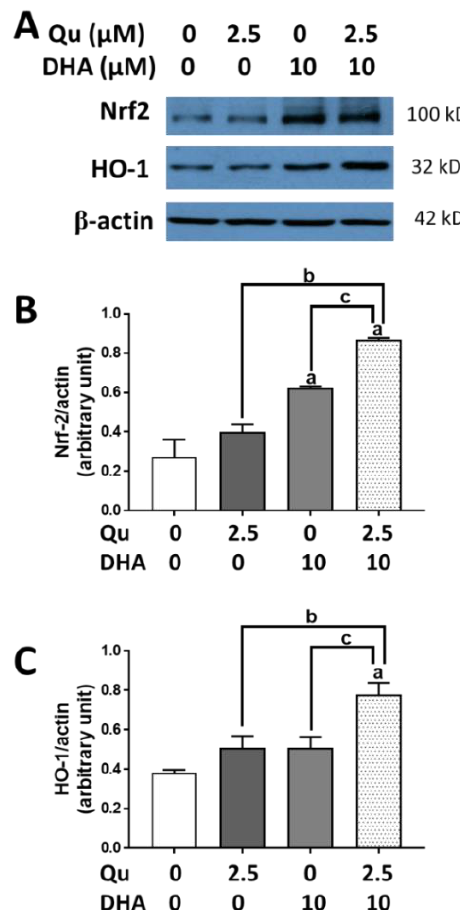
Figure 5. Effects of DHA and/or quercetin on induction of Nrf2 and HO-1 protein expression in BV-2 microglial cells. ( A ) A representative Western blot showing effects of DHA and/or quercetin on Nrf2 and HO-1 expression with β -actin as loading control. ( B , C ) Bar graphs represent relative densities of Nrf2/ β -actin and HO-1/ β -actin ratios from three experiments with different passages. “a” represents significant differences ( p < 0.01) comparing between control versus treatment. “b” and “c” represent significant differences ( p < 0.05) between the indicated pairs.